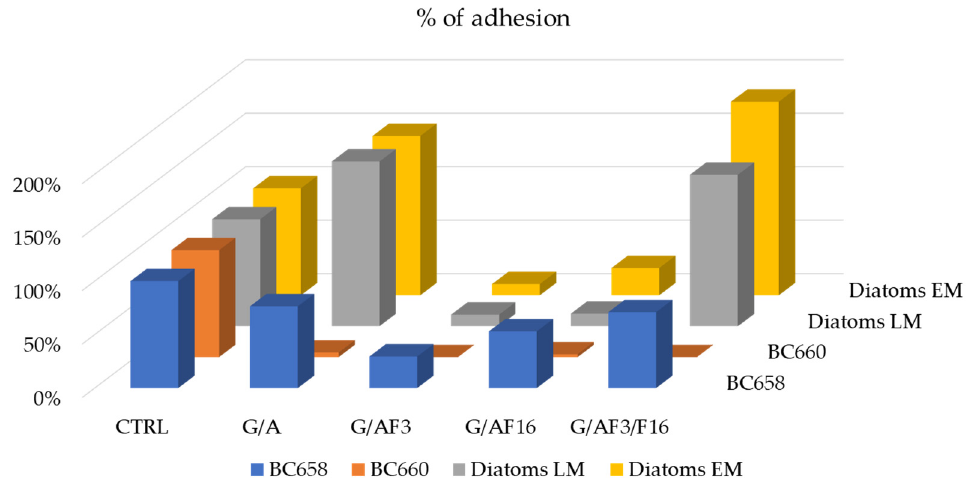
Figure 11. Histogram of the percentage of adhesion on the treated surface of glass slides compared to the adhering cells on the untreated glass slides. For diatoms were reported the results obtained by using two different microscopes (LM and EM).